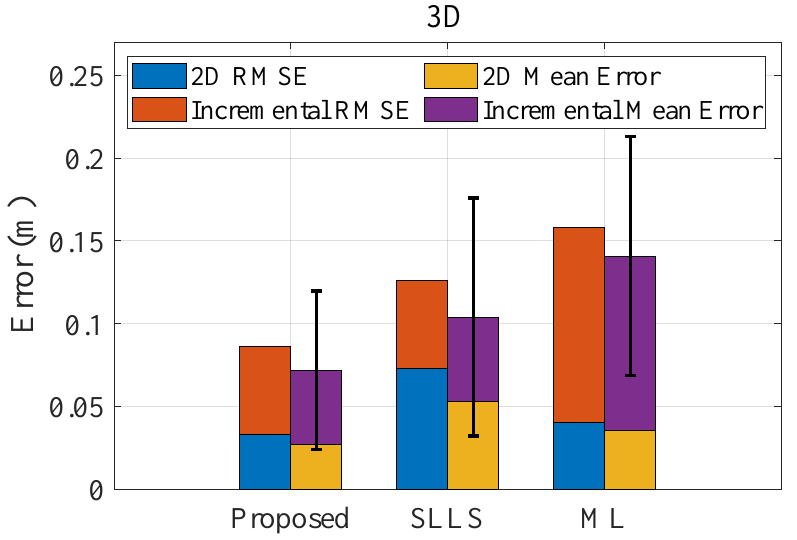
Figure 9. The overall 3D positioning result; error bars donate